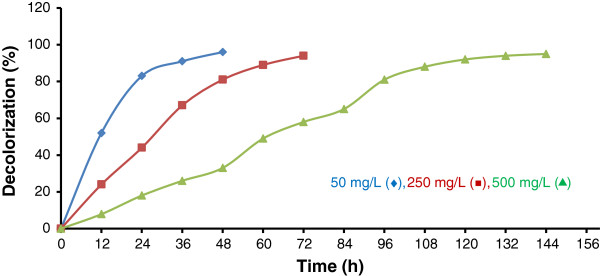
The percentage of RB5 decolorization at various initial dye concentrationsin the biological process.